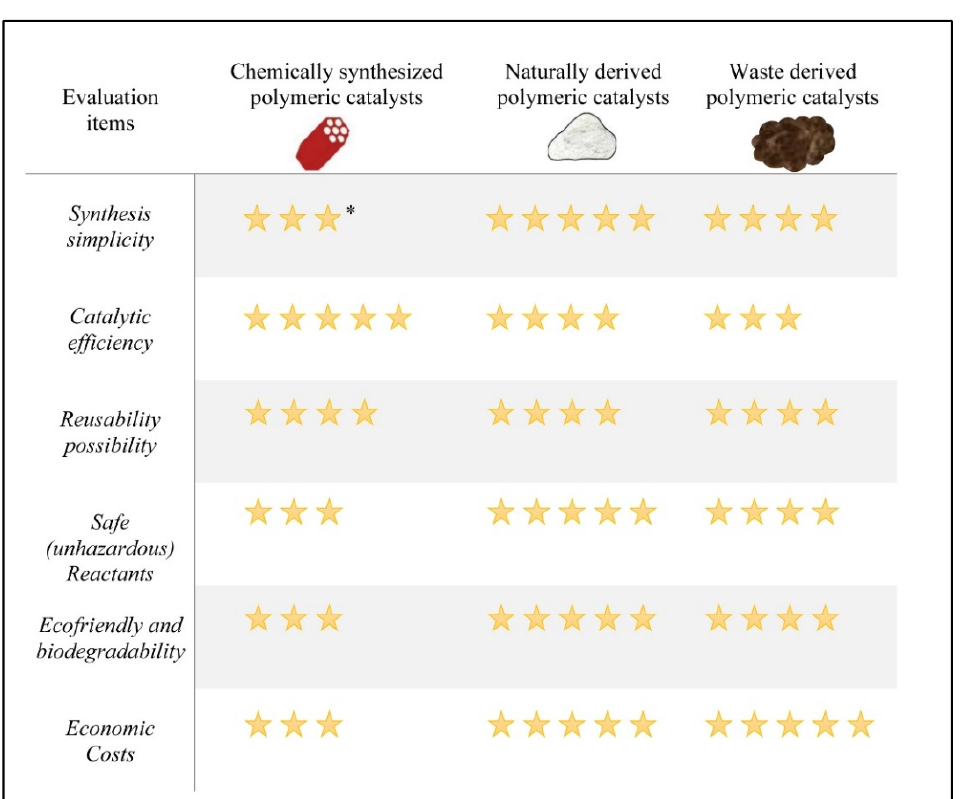
Figure 5. Overall evaluation of biodiesel polymeric catalysts. * Stars refer to the goodness of the evaluated characteristic, 5 stars mean very good, 4 stars are good, and 3 stars refer to acceptable evaluation.